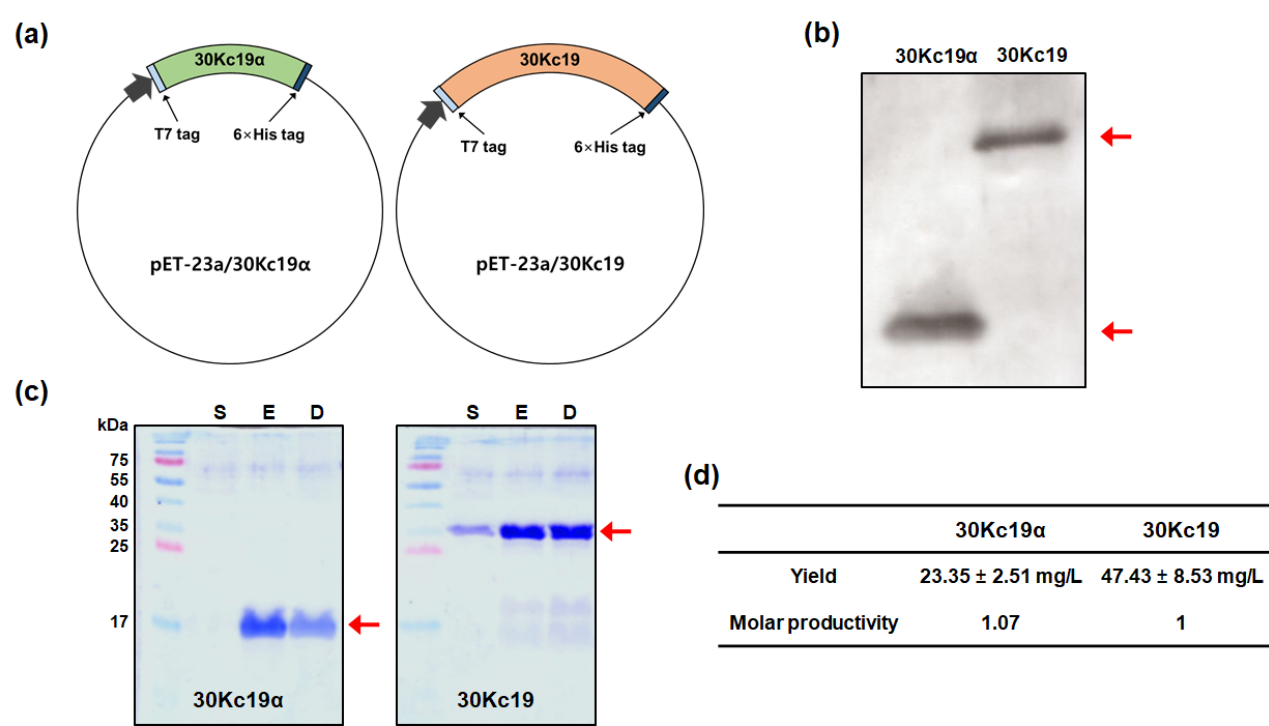
Figure 1. Construction of recombinant 30Kc19α and its expression in E. coli in comparison with 30Kc19: ( a ) construction of E. coli expression vectors pET-23a/30Kc19α and pET-23a/30Kc19; ( b ) Western blot results; ( c ) sodium dodecyl sulfate-polyacrylamide gel electrophoresis (SDS–PAGE) of 30Kc19α and 30Kc19 expressed in soluble form. M, protein maker; S, soluble cell lysate; E, proteins eluted from Ni-NTA affinity chromatography column; D, finally dialyzed protein; ( d ) comparison of production yields of 30Kc19α and 30Kc19 after chromatography-mediated purification and dialysis.